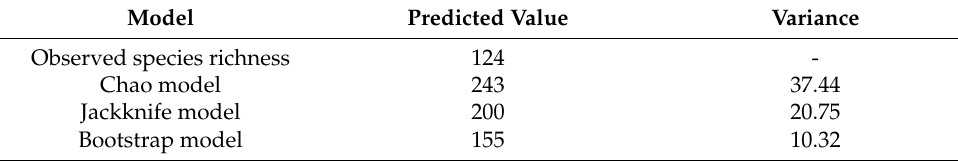
Table 3. Predicted results of the three models.